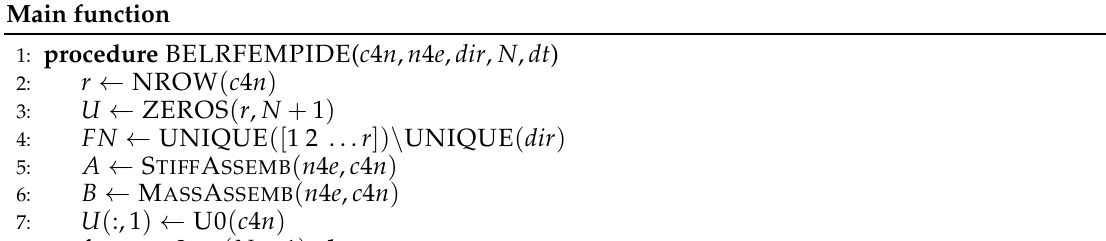
Algorithm A1 Backward-Euler scheme with left rectangular rule. Main